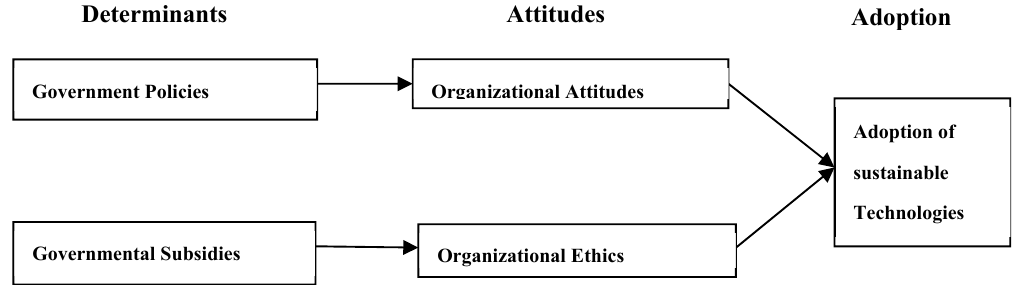
Figure2. Figure 2. Partial least squares structural equation modeling (PLS-SEM) Path Theoretical Research Model .